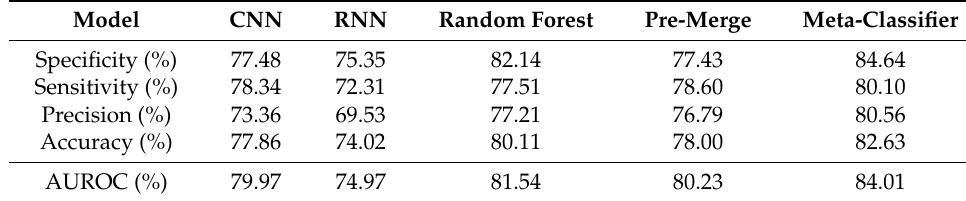
Table 6. Testing results for the proposed sleep-arousal detector.